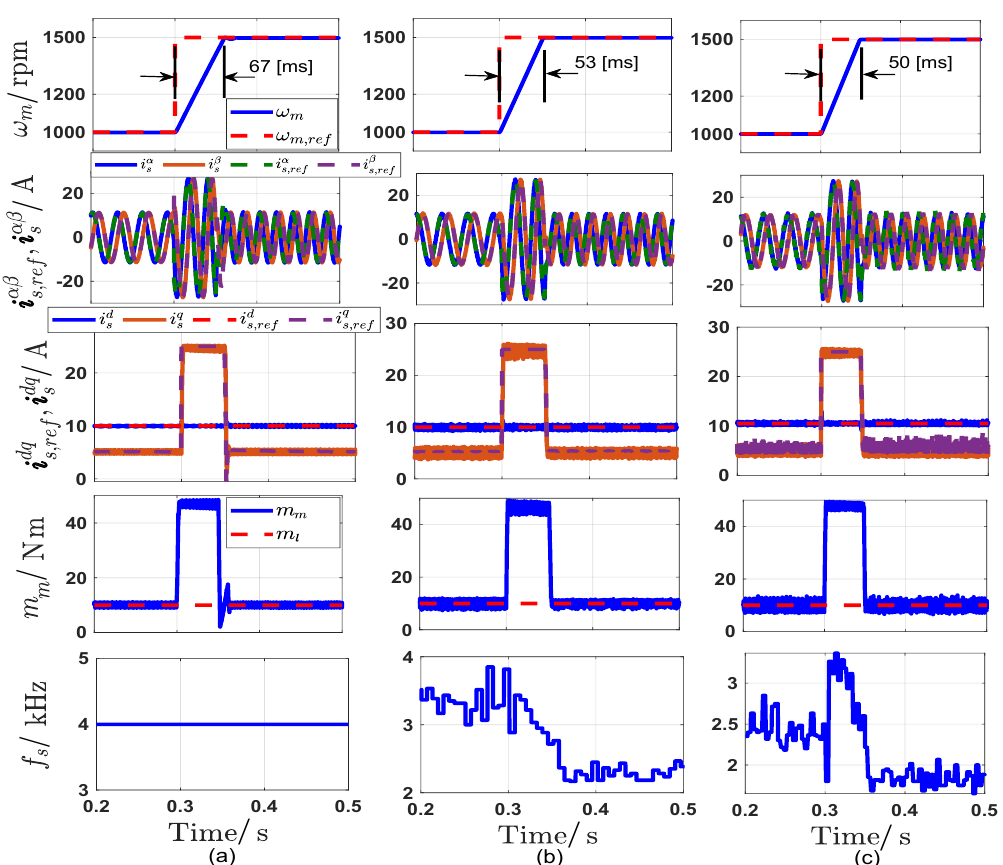
Figure 12. Dynamic performance of the different control strategies under a step change of rotor mechanical speed form 1000 rpm to 1500 rpm: ( a ) FOC, ( b ) CPC, and ( c ) Proposed